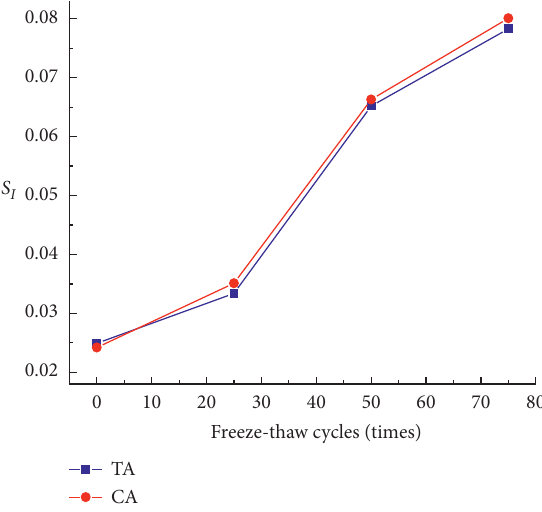
Figure 9: Relationship of test values and calculation